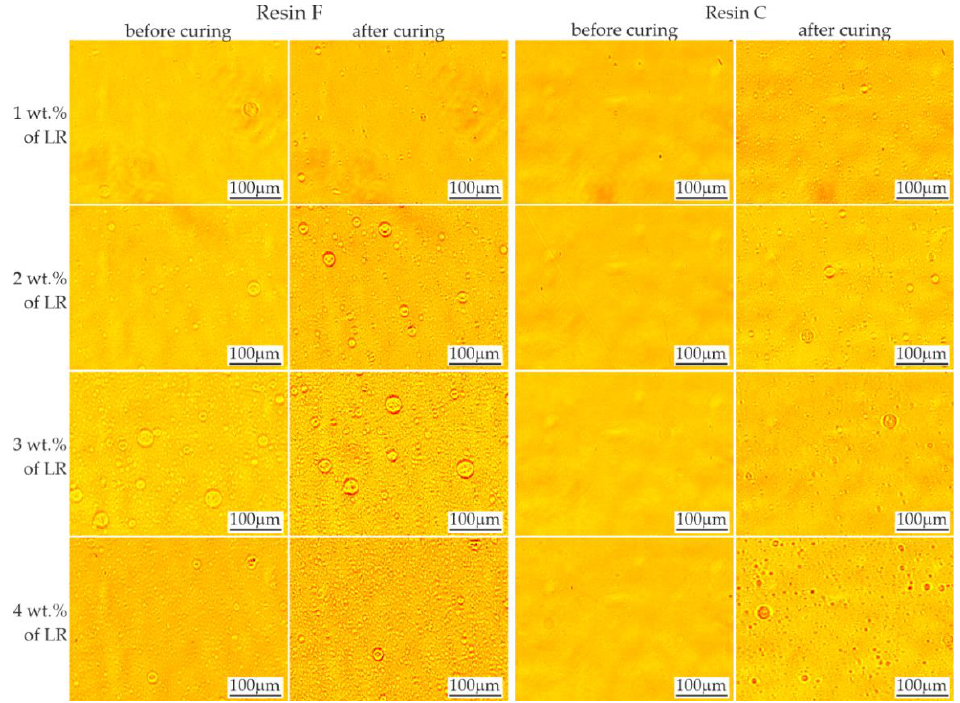
Figure 2. Evaluation of rubber miscibility in resins F and C. Rubber domains are visible as round objects.